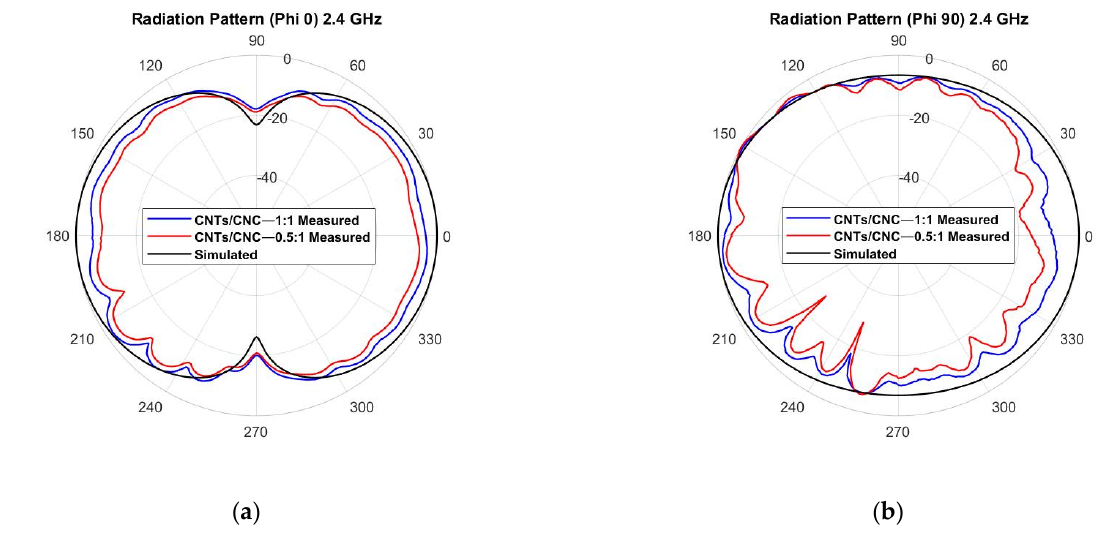
Figure 18. Measured vs. simulated radiation pattern of the graphene-based textile LOOP antenna in free space, E -plane cut at φ = 90° and H -plane cut at φ = 0°.